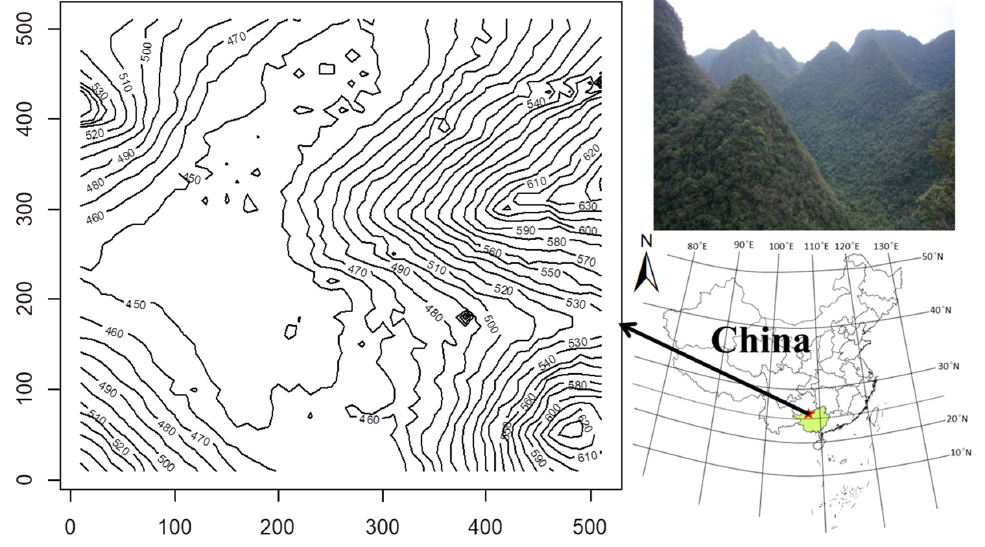
Figure 1. The 25 ha Mulun forest plot and the contour map of the plot. The numbers in the contour map represent elevation (m).